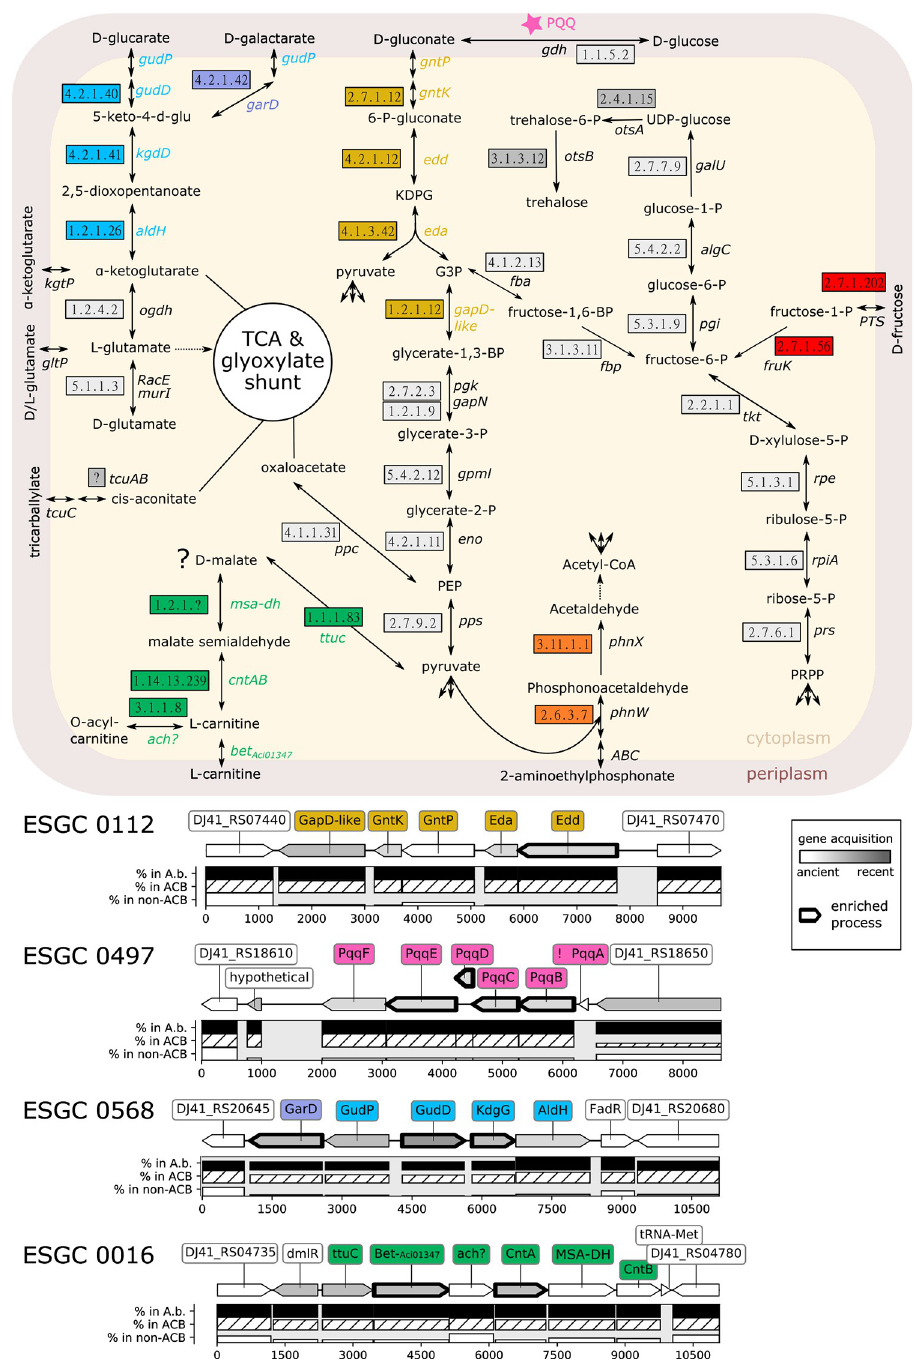
Fig 9. Members of the ACB clade have extended their basal carbohydrate metabolism. The pathway map shows a model integrating four metabolic pathways represented by the ESGC ACB -0112 (Entner-Doudoroff pathway; yellow), 0497 (biosynthesis of Pyrroloquinoline quinone; magenta), 0568 (glucarate/galactarate catabolism; blue/violet) and 0016 (carnitine catabolism; green) into the bacterial carbohydrate metabolism (grey boxes). Abbreviations: KDPG— 2-keto-3-deoxy-6-phosphogluconate; G3P –glycerinealdehyde-3-phosphate. The corresponding gene clusters are shown below the pathway map with one protein-coding flanking gene on either side that is not part of the cluster. The layout follows Fig 7. ESGC ACB -0112: GapD-like–glyceraldehyde-3-phosphate dehydrogenase [1.2.1.12]; GntK— gluconokinase [EC:2.7.1.12]; Edd—phosphogluconate dehydratase [EC:4.2.1.12]); Eda—2-dehydro- 3-deoxyphosphogluconate aldolase / (4S)-4-hydroxy-2-oxoglutarate aldolase [EC:4.1.2.14 4.1.3.42];